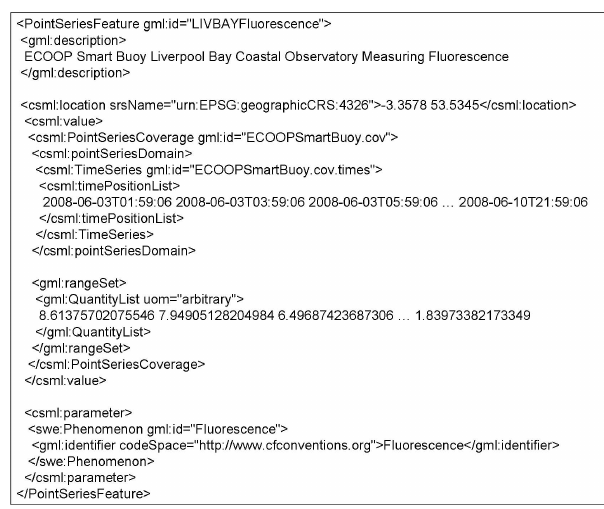
Fig. 4. Example of CSML XML returned from the WFS, represent- ing sea water temperature data from the Liverpool Bay SmartBuoy. Note that the 10-day list of times and values as been truncated for